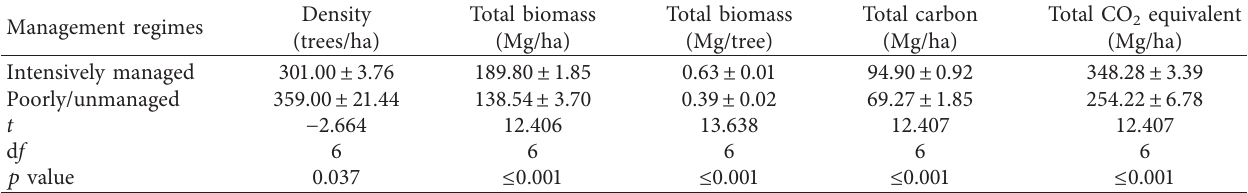
Table 8: Tree density, total biomass, and carbon stock in intensively and poorly managed Tectona grandis plantations. Management